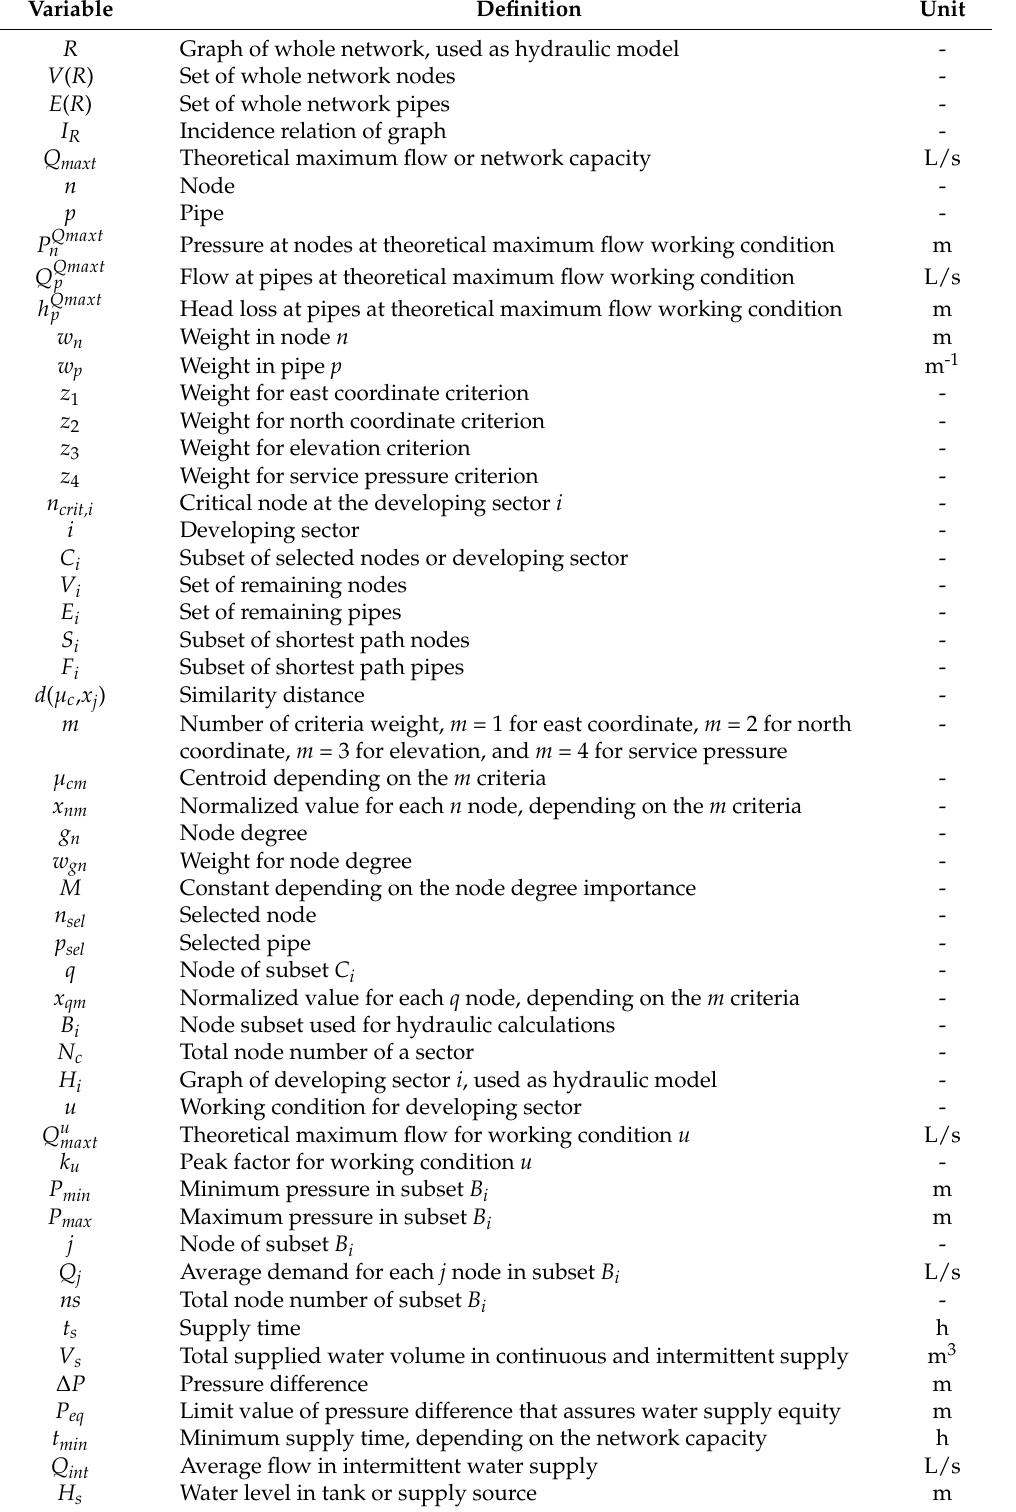
Table 1. List of used